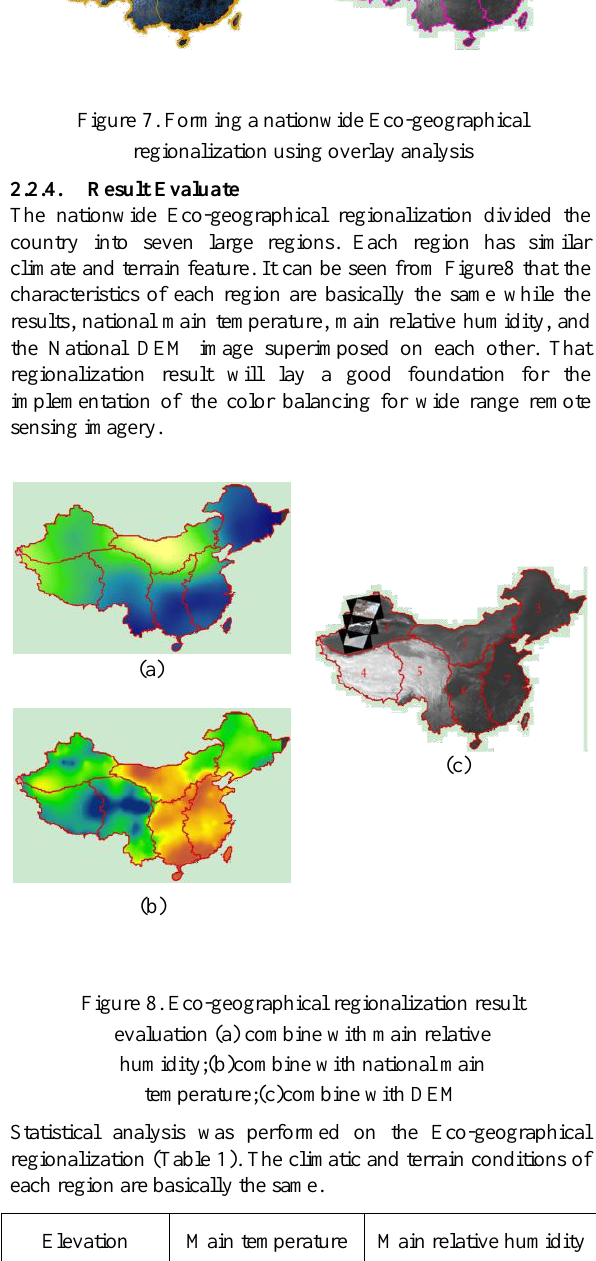
Figure 6. Classification, segmentation, vectorization of national SRTM250m DEM data